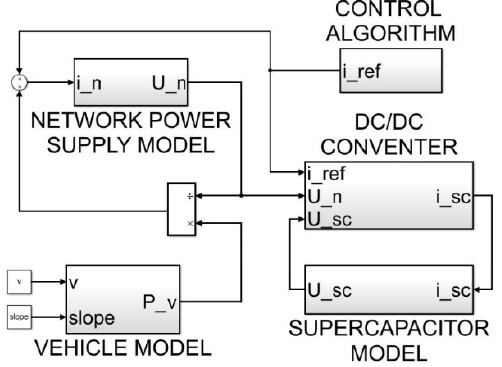
Figure 2. Regenerative braking system block model.